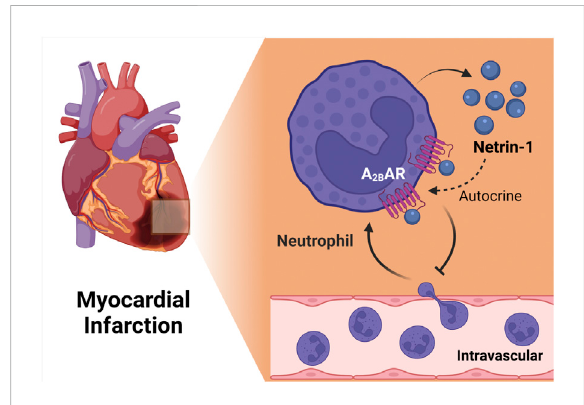
FIGURE 5 The netrin-1/Adora2b link in ischemia reperfusion injury of the heart. Myeloid cell derived netrin-1 has shown to be important for cardiac protection during ischemia reperfusion injury. Netrin-1 level increases during in situ myocardial infarction in mice and antibody mediated depetion of neutrophil abolished the induction, suggesting the importance of neutrophil as key sources of netrin-1. Furthermore, studies using treatment of recombinant netrin-1 implicated myeloid-dependent Adora2b signaling in cardioprotection, since the protection provided by netrin-1 treatment was completely abolished in Ntrn1 loxp/loxp Myosin Cre + mice. Together, these fi ndings implicate neutrophil-dependent netrin-1 release in mediating cardioprotection from ischemia and reperfusion by activating myeloid-dependent Adora2b adenosine